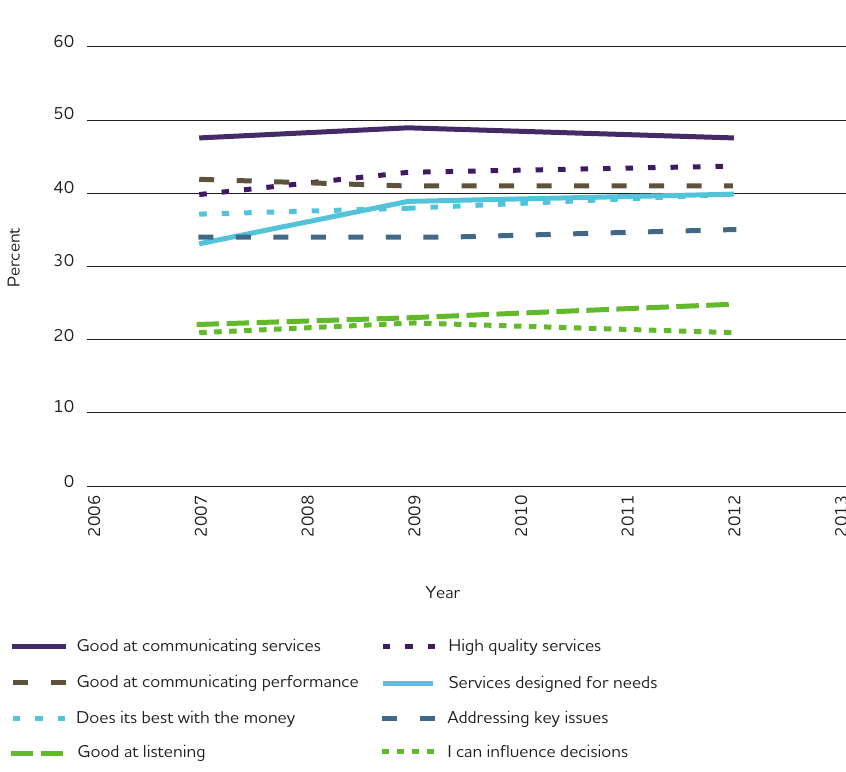
Figure 13: Trends in Overall Satisfaction with Local Government in Scotland